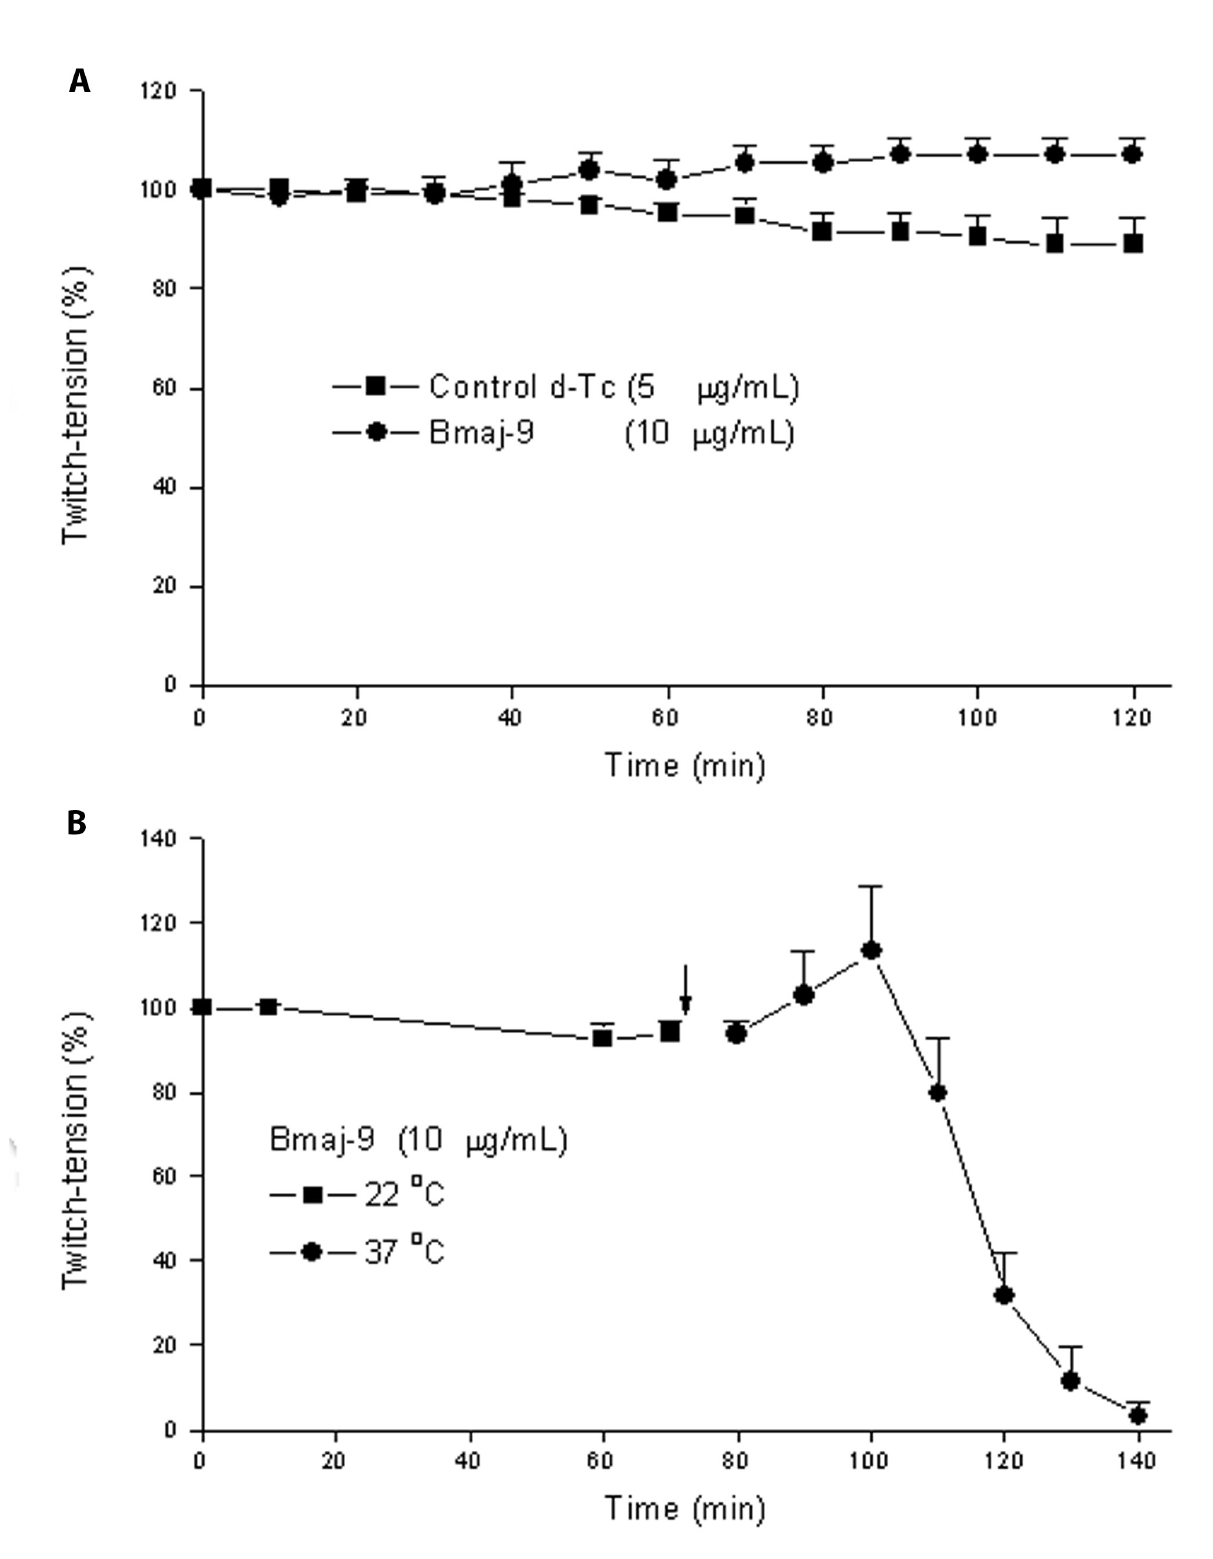
Figure 6. ( A ) Effect of Bmaj-9 (10 µg/mL) on curarized preparations. Note the absence of effect in the muscular response to direct electrical stimulation. ( B ) The characteristic neuromuscular blockade was not observed when the preparations were incubated with Bmaj-9 (10 µg/mL) at low temperature